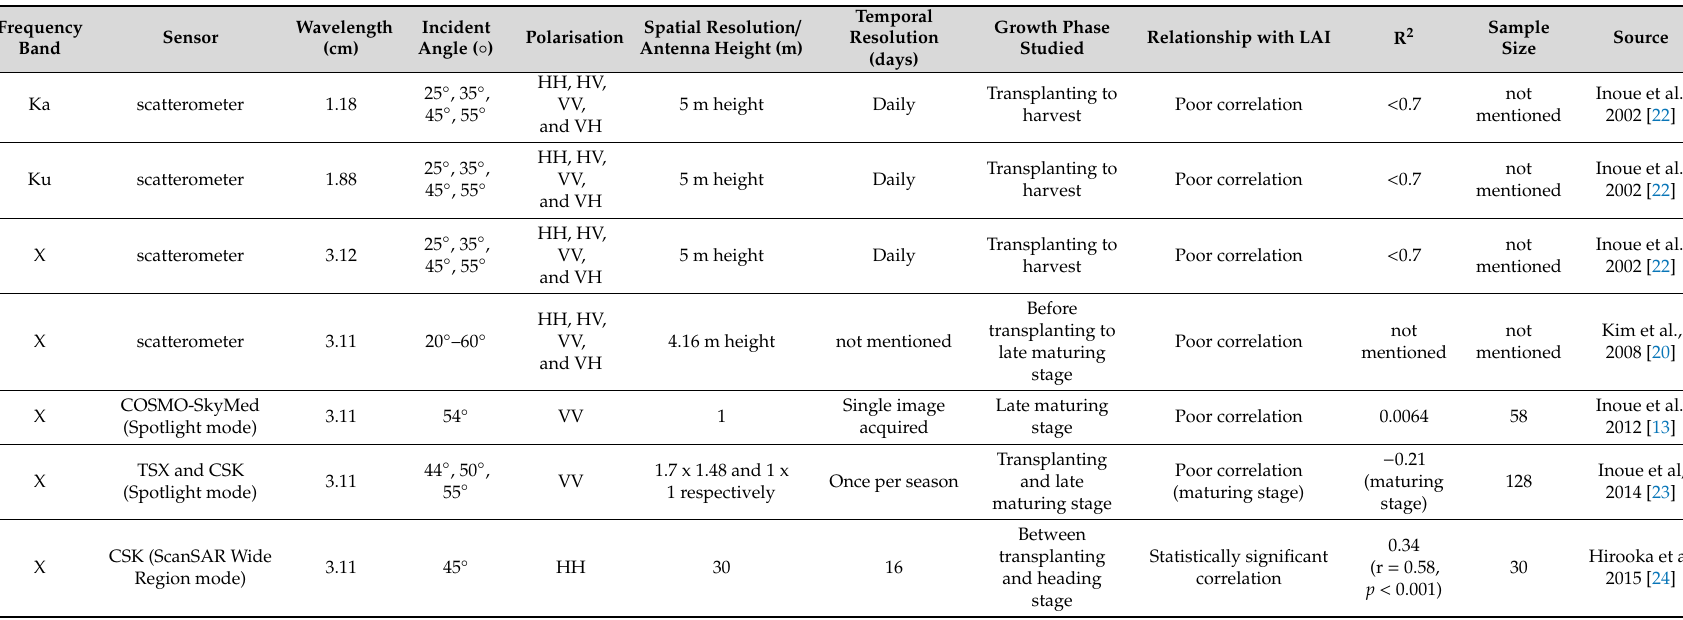
Table 1. Summary of studies over the years on the relationship of rice crop’s leaf area index (LAI) with Ka, Ku and X-band backscattering intensity ( σ ◦